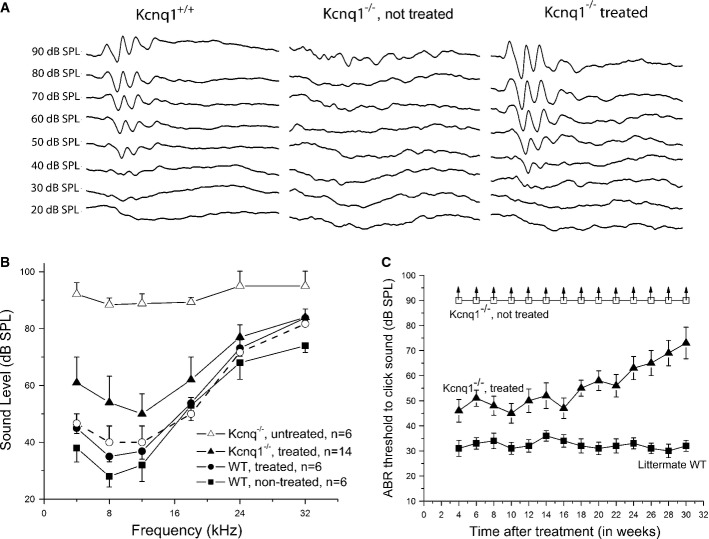
Comparison of the ABR data from WT, treated, and untreated Kcnq1−/− mice
Waveforms of ABRs are compared in WT, untreated Kcnq1−/−, and treated Kcnq1−/− mice, as labeled above data traces. Series of averaged ABR data traces were evoked from tone-burst sounds with intensities ranging from 20 to 90 dB SPL.

Summary of averaged ABR thresholds at various frequencies for different groups of mice; untreated Kcnq1−/− (open triangles), treated Kcnq1−/− (filled triangles), injected WT (filled circles), and uninjected WT (filled squares). Plot legends are given in the figure. The plot with open circles connected with dashed lines represents average data from the five best cases of treated Kcnq1−/− mice. Error bars represent standard error of the mean.

Click-evoked ABR thresholds of WT (filled squares), treated Kcnq1−/− mice (filled triangles), untreated Kcnq1−/− mice (open squares) measured 4–30 weeks after mice were born. Error bars represent standard error of the mean. Upward arrows indicate that click-ABR thresholds were at the maximal sound level that could be reliably measured by the system.